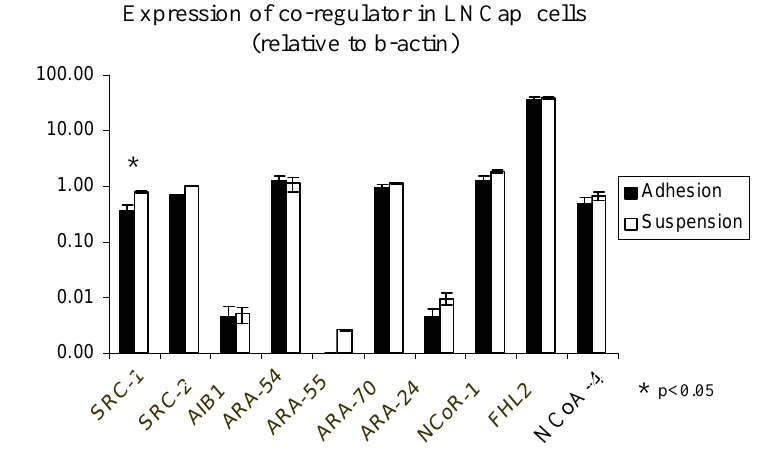
Figure 4. A The regulation of AR-coregulators in adherent and suspended PC-3-AR cells. Real -time PCR was done in triplicate with SYBRA Green Master Mix. ABI 7700 sequence detector and SDS 1.9.1 software were used for PCR reaction and data analysis. The relative values normalized to B-actin were presented. * indicated P<0.001. B.The regulation of AR-coregulators in adherent and suspended LNCap cells. Experiment was similar, and *indicated